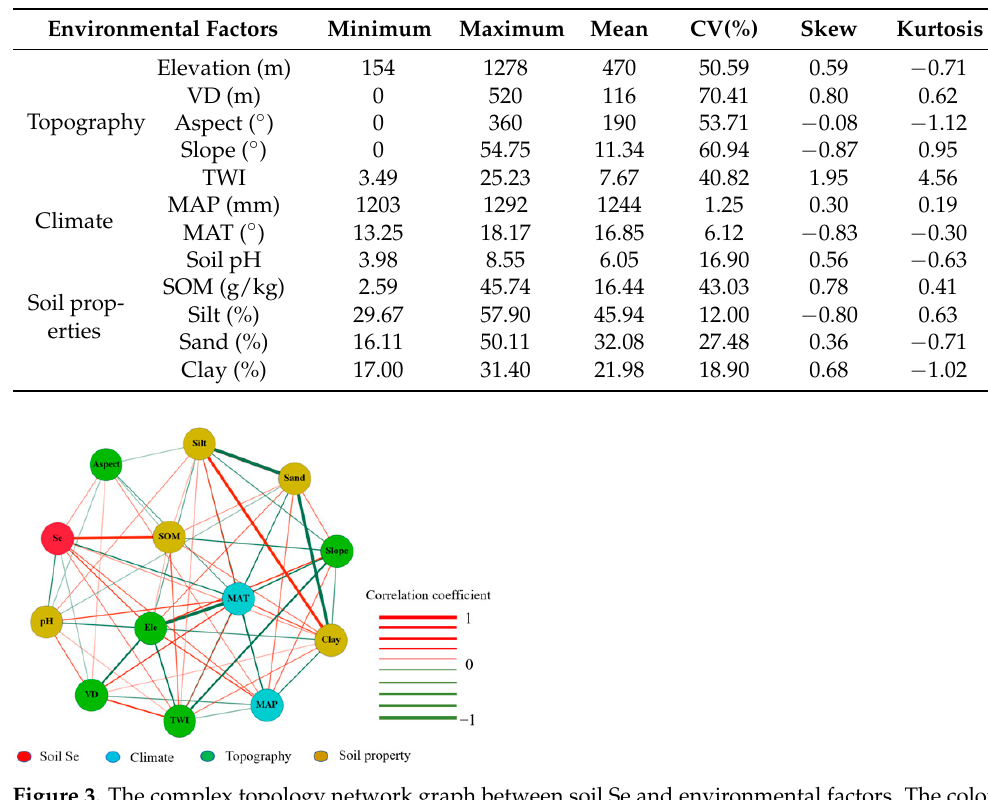
Figure 3. The complex topology network graph between soil Se and environmental factors. The color of edges suggests positive (red) and negative (green) correlation between nodes, and the stronger the correlation, the thicker the edges. The range of correlation coefficients between the factors is − 0.10–0.66. Ele: elevation. Table 3. Soil Se content (mean ± standard deviation, mg/kg) in different soil parent materials ( n = 2804).